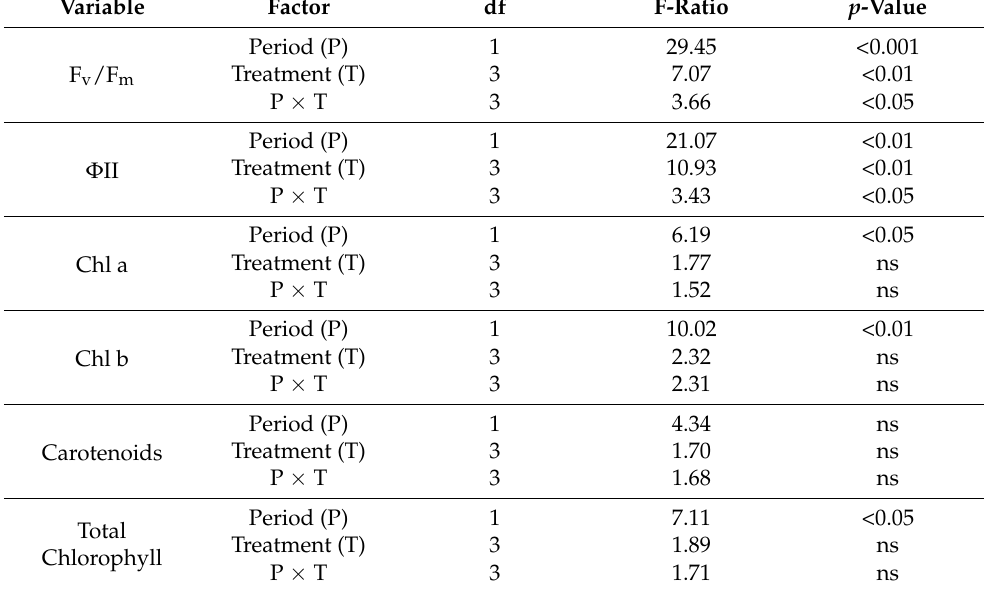
Table 2. Results of two-way ANOVAs showing the effects of different paracetamol treatments, exposure periods, and their interactions on chlorophyll fluorescence (F v /F m and Φ II), Chl a, Chl b, carotenoids, and total chlorophyll content (mg/g FW) in spinach. Variable Factor df F-Ratio p -Value Period (P) 1 29.45 <0.001 Treatment (T) 3 7.07 <0.01 F v /F m P × T 3 3.66 <0.05 Period (P) <0.01 Φ II Treatment (T) <0.01 P × T Period (P) <0.05 Treatment (T) 3 1.77 Chl a P × T 3 1.52 Period (P) 1 10.02 <0.01 Treatment (T) Chl b P × T ns Period (P) 1 4.34 ns Treatment (T) 3 1.70 Carotenoids P × T 1.68 ns Period (P) <0.05 Total Treatment (T) 3 1.89 ns Chlorophyll 1.71